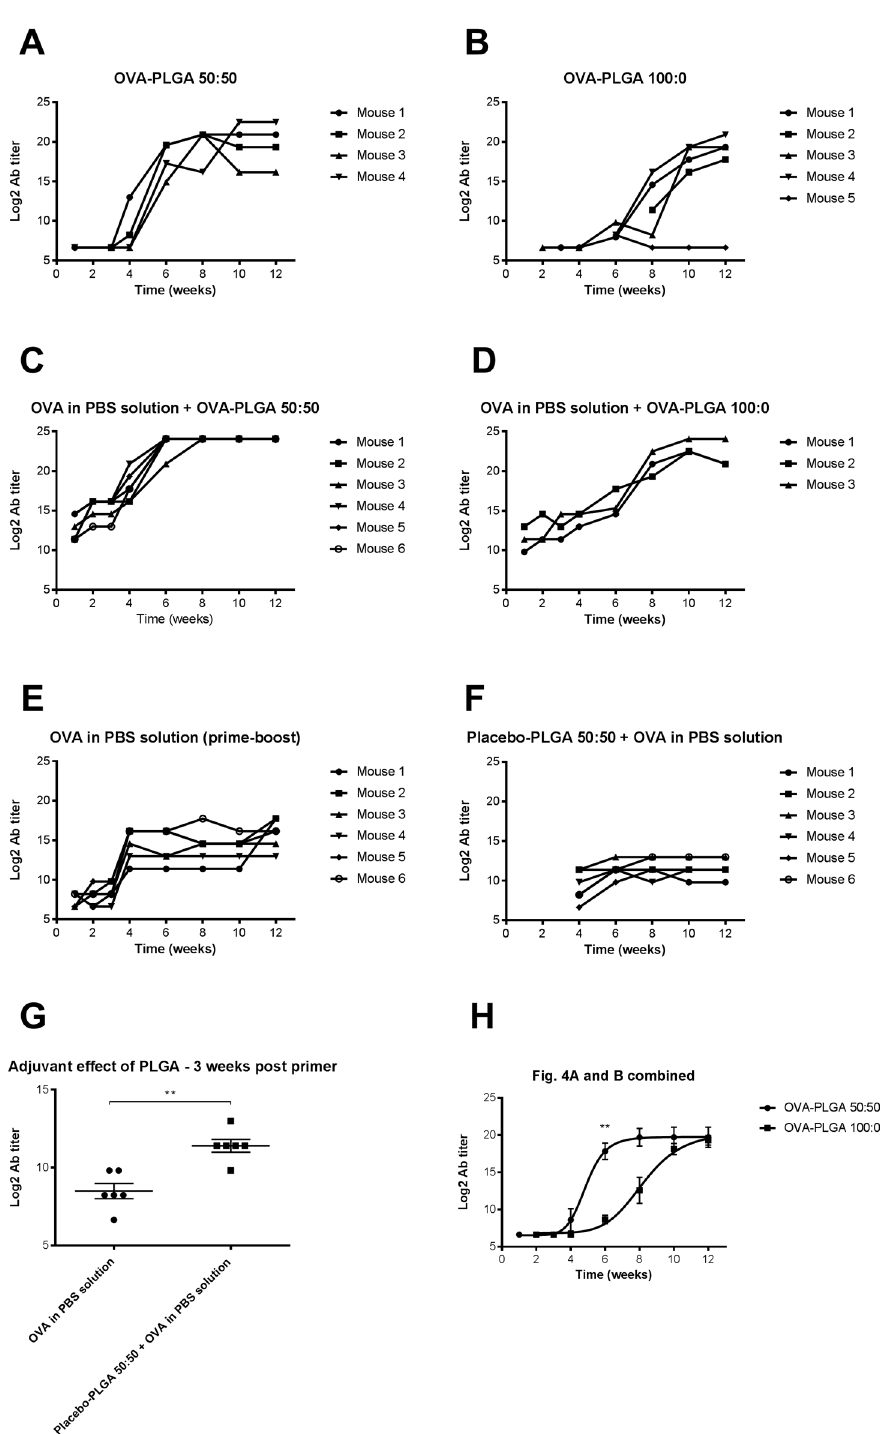
Fig 4. A-H. IgG1 antibody titers over time after immunization. Mice were immunized with OVA-PLGA 50:50 core- shell implant (A), with OVA-PLGA 100:0 core-shell implant (B), with OVA dissolved in PBS together with OVA-PLGA 50:50 core-shell implant (C), with OVA dissolved in PBS together with OVA-PLGA 100:0 core-shell implant (D), with OVA dissolved in PBS, primer (day 0) and booster (day 21) (E), placebo-PLGA50:50 core-shell implant (day 0) followed by OVA dissolved in PBS at day 21 (F). OVA in PBS solution (prime-boost) vs. placebo- PLGA 50:50 + OVA in PBS solution 3 weeks after injection of the primer to investigate adjuvant effect of PLGA.